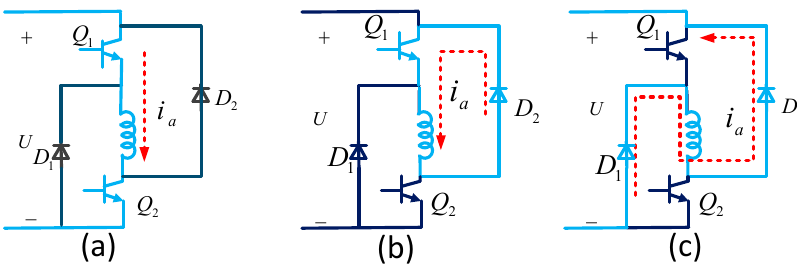
Figure 2. Three modes include ( a ) excitation, ( b ) freewheeling, and ( c ) demagnetization.